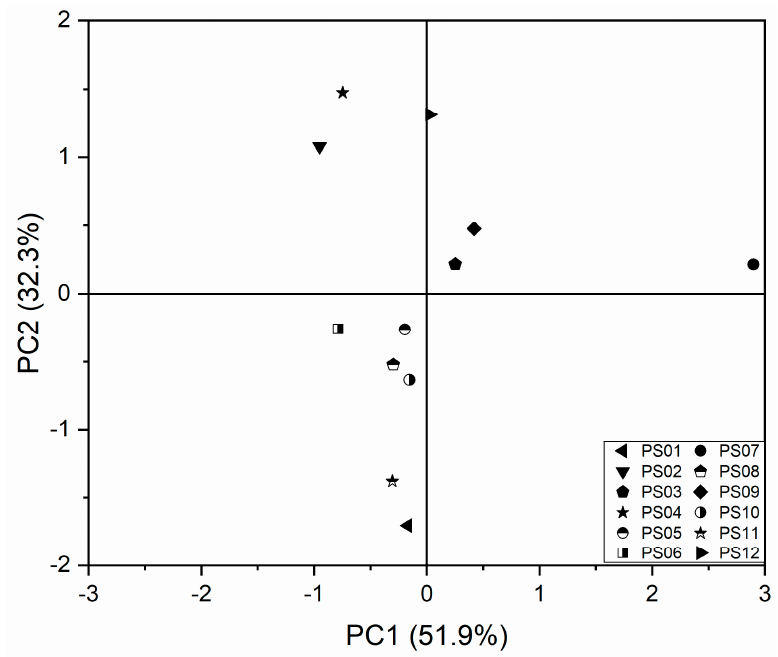
Figure 4. PCA core plots for 600 MHz 1 H-NMR spectra of SMB extracts from 12 collection areas.